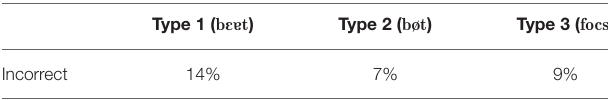
TABLE 4 | Proportions of incorrect answers to nonces in Experiment 1.